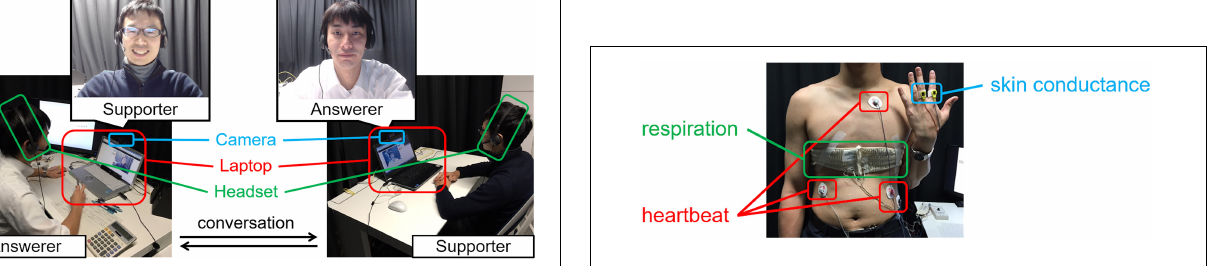
FIGURE 1 | Communication system used during the pair improvement period in the creative problem-solving task.